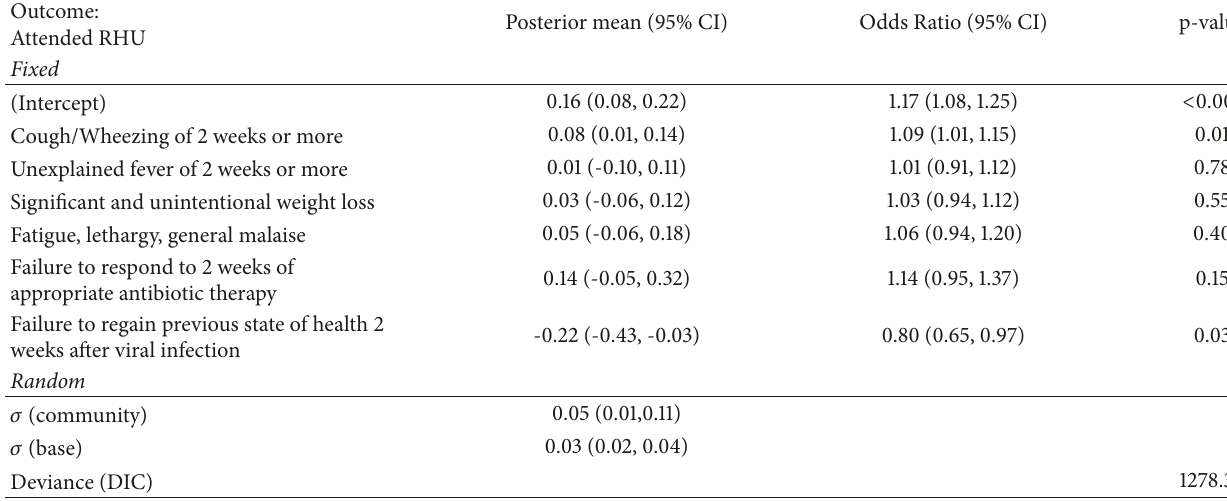
Table 3: Factors associated with successful attendance at a Rural Health Unit (Markov chain Monte Carlo (MCMC) generalized linear mixed-